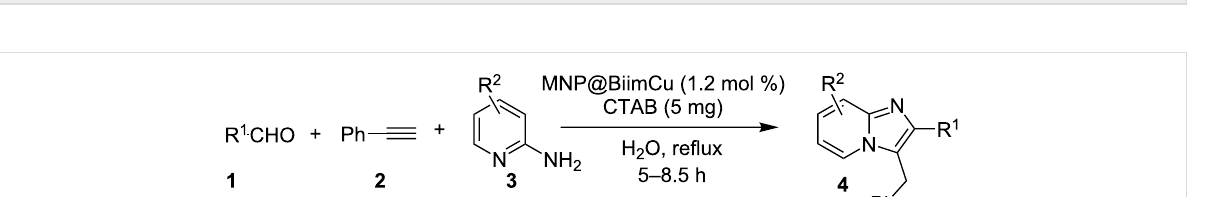
Scheme 8: Mechanism involving oxidative C–H functionalization.